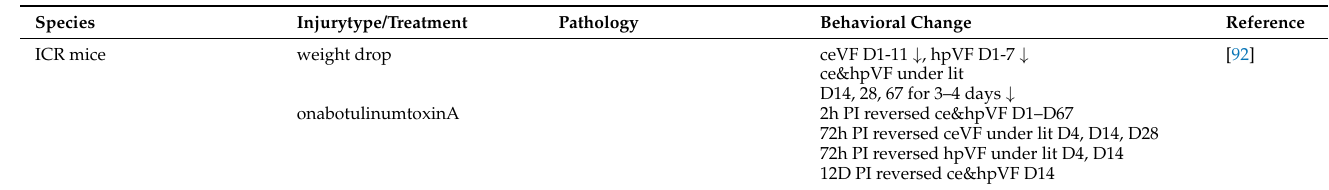
Table 1. PTH models treated with potentially therapeutic